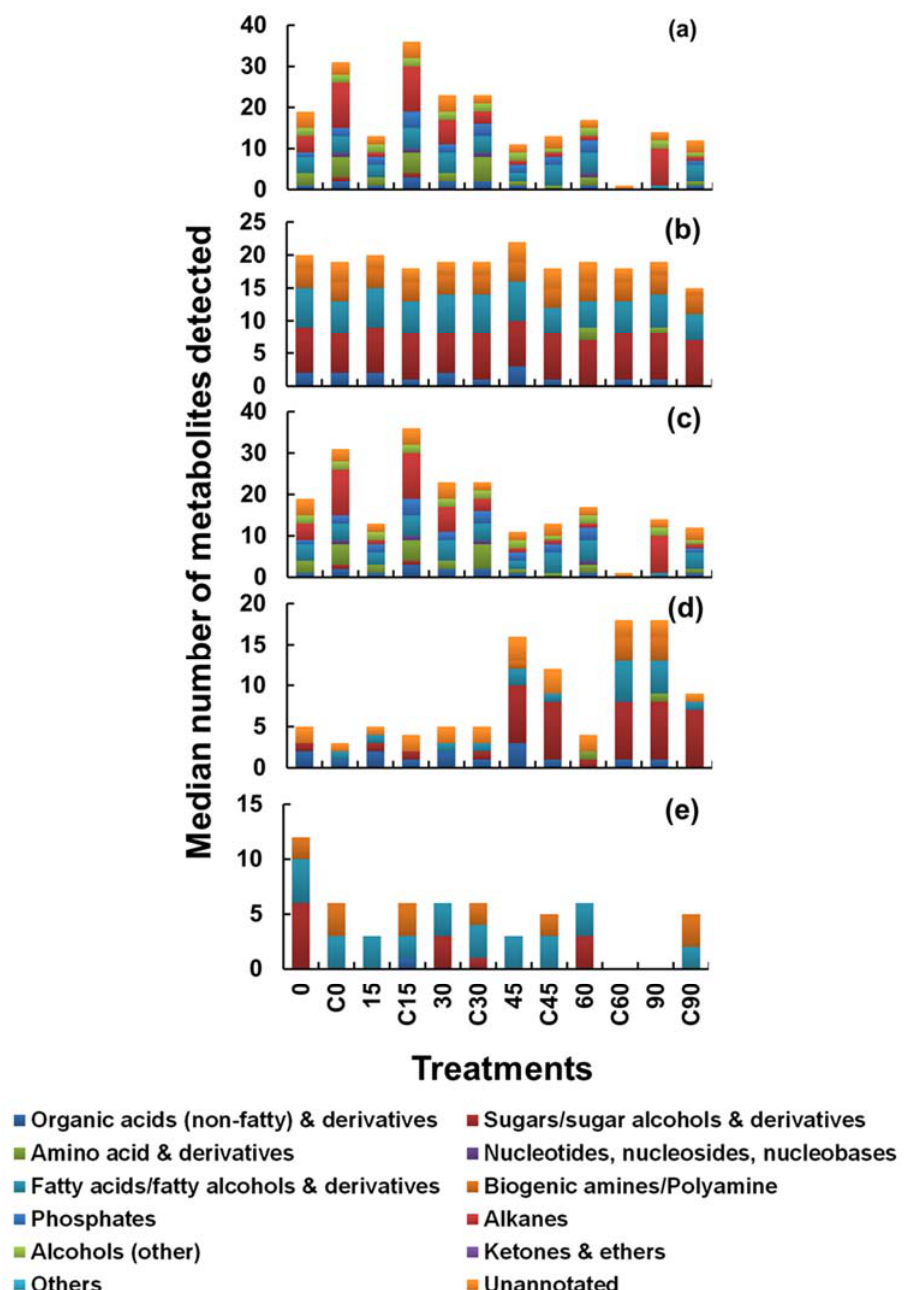
Figure 4. A summary of the unique recovery efficiency of all the six quenching treatments involved in Approach 2. The X-axis represents different time intervals along with their control samples (C), for each time interval. After all treatments the extracted metabolites from cell extracts, cell-free supernatant post quenching and blank samples were analysed by GC-MS. ( a ) Metabolites identified in cell extracts only, ( b ) metabolites identified in supernatant only, ( c ) metabolites present only in cell extract (and not in the supernatant)—unique to cells, ( d ) metabolites present only in supernatants (and not in cell extract)—unique to supernatants, ( e ) metabolites present in both the cell extract and supernatant—(common to